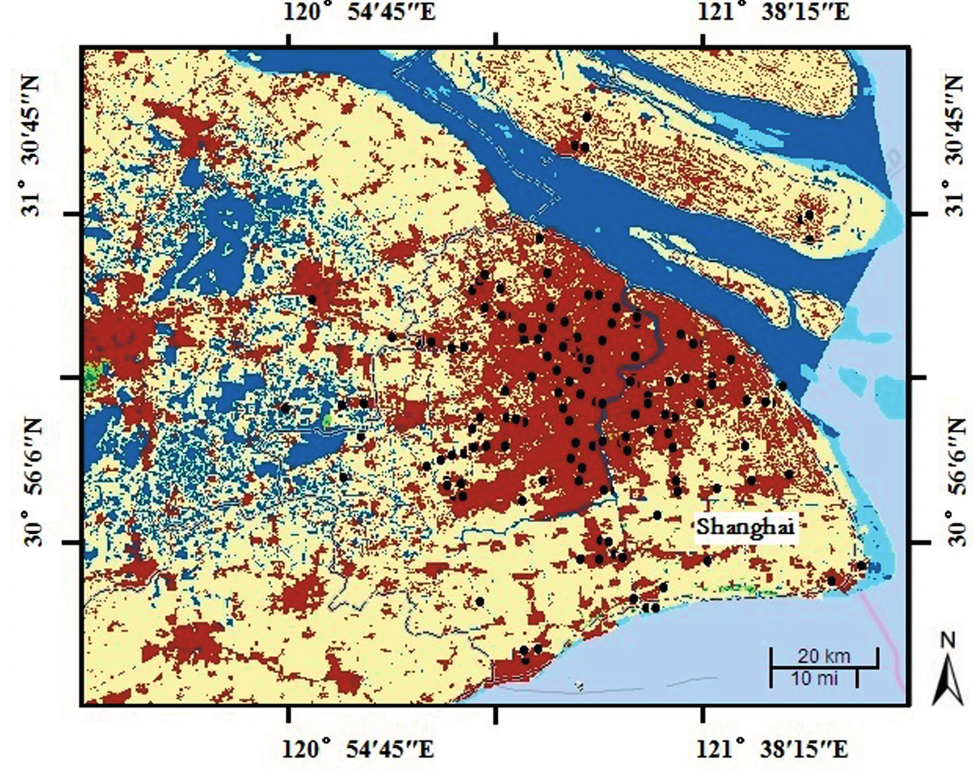
Figure 7. Distribution of geo-tagged web texts in Shanghai on